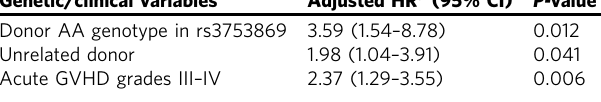
Table 2 Multivariate analysis of the association of APCS SNPs with the risk of IPA among transplant